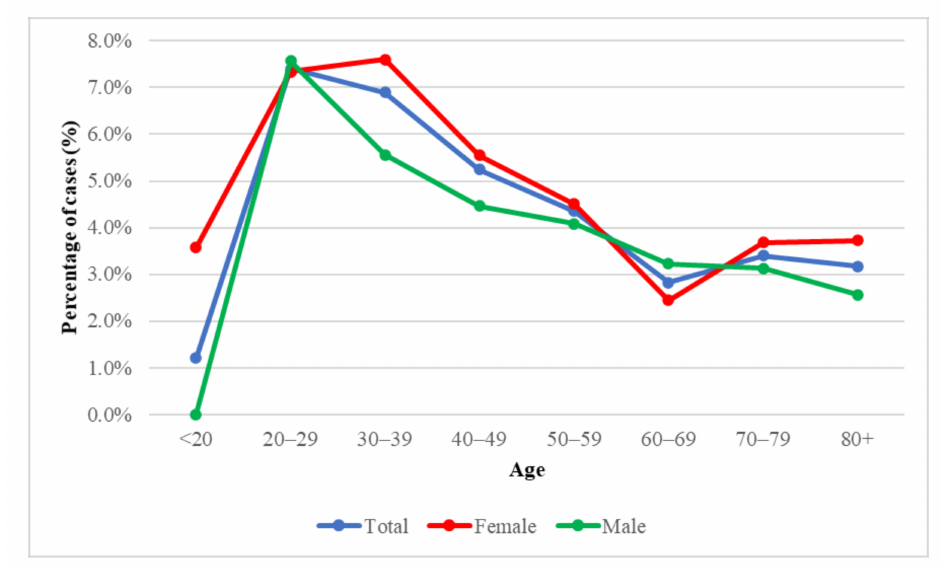
Figure 5. SARS CoV-2 infection in oncology patients by age and